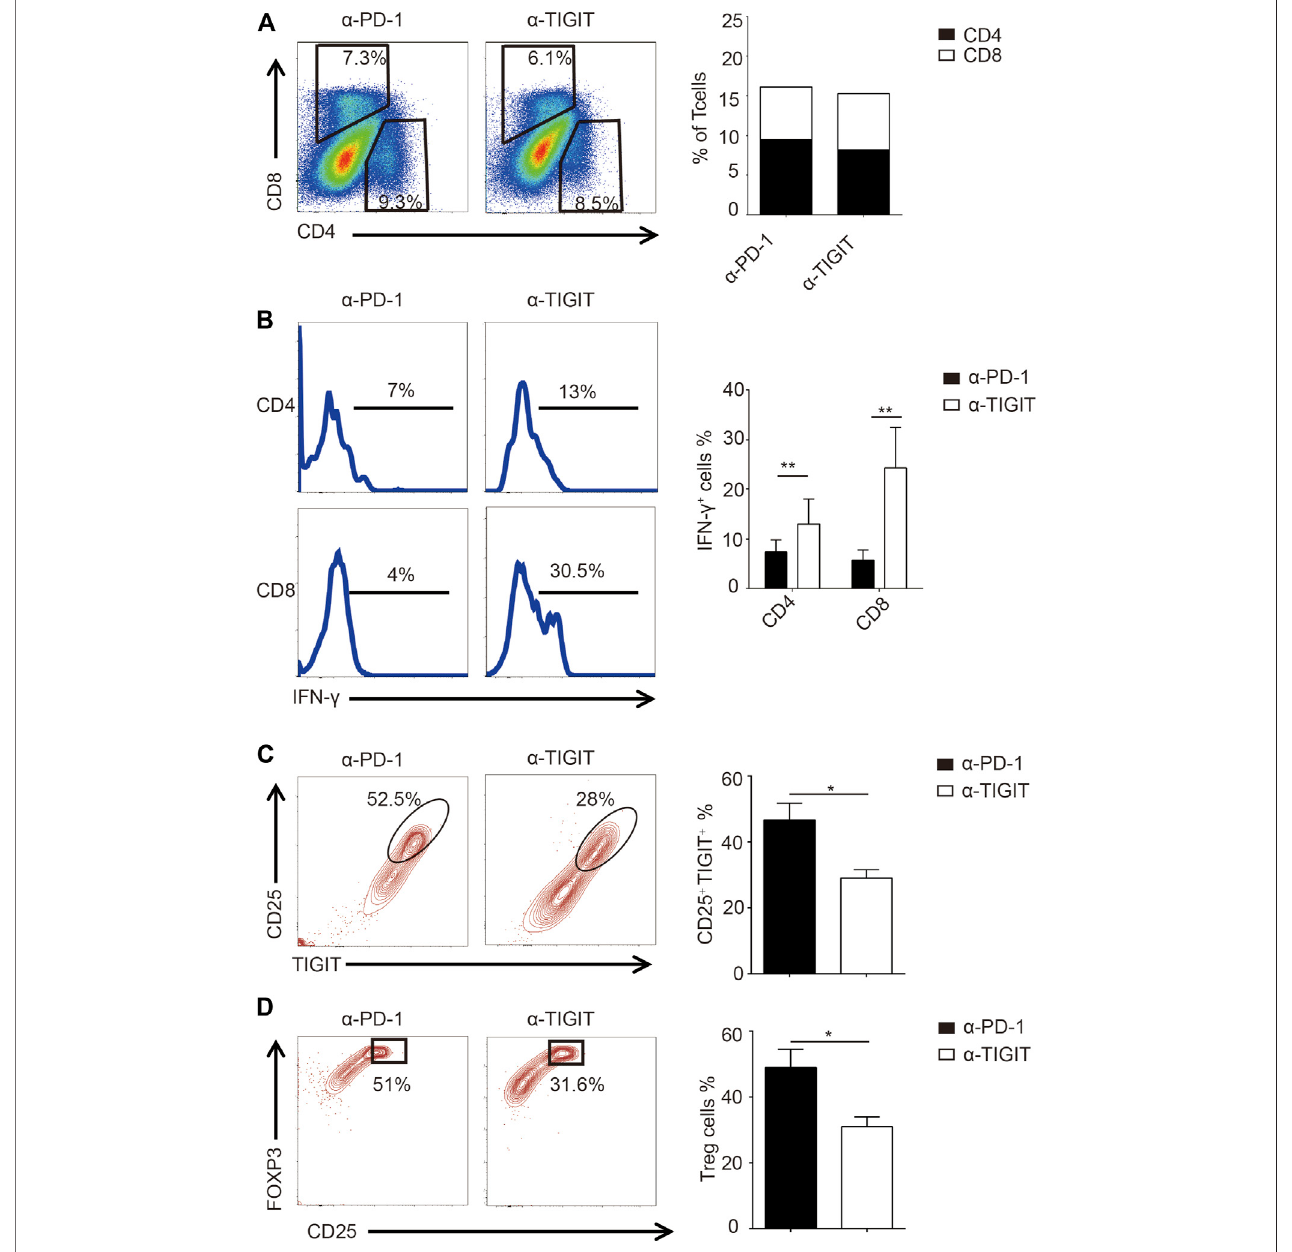
FIGURE5| TargetingTIGITpromotedtheantitumorcapabilityofTcells. (A) Administrationof α -TIGITdoesnotaffecttheratiosofCD4 + andCD8 + T-cellsinbladder cancer tissues. Dot plots represent the frequencies of CD4 + and CD8 + T cells in murine bladder cancer tissues from three independent experiments (n (cid:1) 6) (left panel) . The ratios of CD4 + and CD8 + T cells are shown as the mean (right panel) . (B) Administration of α -TIGIT upregulates the secretion of IFN- γ in T cells. Numbers in histograms show the representative ratios of IFN- γ + T cells from three independent experiments (n (cid:1) 6) (left panel) . The ratios of IFN- γ + cells are shown as the mean ± SD. ** p < 0.01; one-way ANOVA (right panel) . (C) Administration of α -TIGIT suppresses the expression of TIGIT in Treg cells. Dot plots represent the ratios of TIGIT + CD25 + subsets in CD4 + T cells from three independent experiments (n (cid:1) 6) (left panel) . The ratios of TIGIT + CD25 + cells are shown as the mean ± SD. * p < 0.05; t -test (right panel) . (D) Administration of α -TIGIT suppresses the generation of Treg cells in mice with bladder cancer. Dot plots represent the ratios of CD25 + FOXP3+ subsets in CD4 + T cells from three independent experiments (n (cid:1) 6) (left panel) . The ratios of CD25 + FOXP3+ cells are shown as the mean ± SD. * p < 0.05; t -test (right panel) .